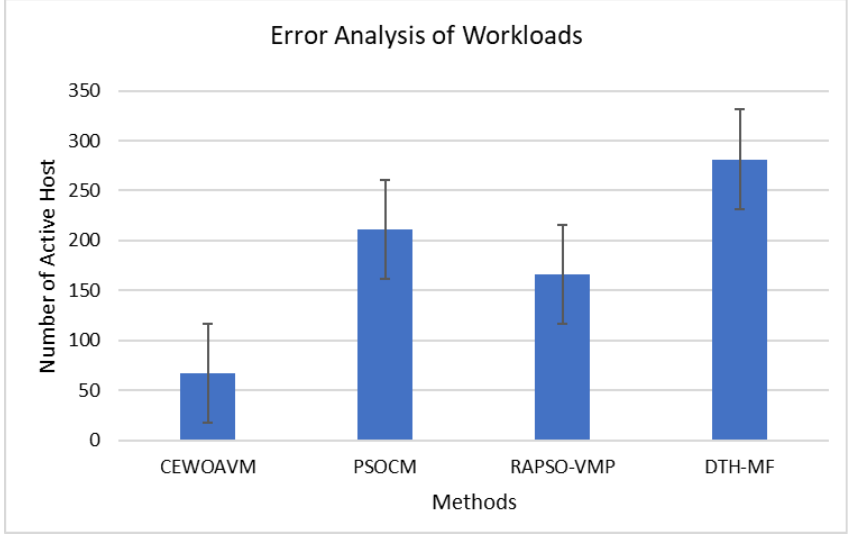
Figure 8. Error analysis bar plot.